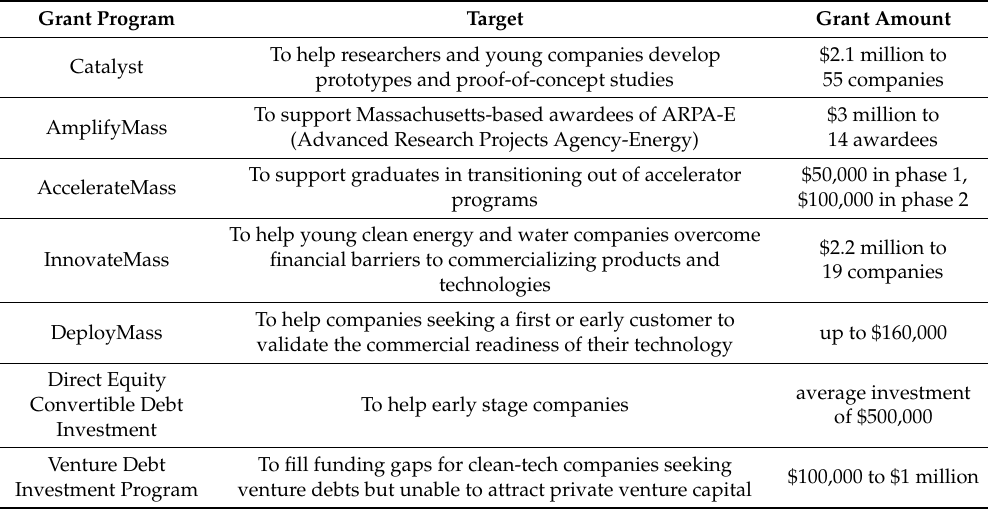
Table 3. MassCEC grant